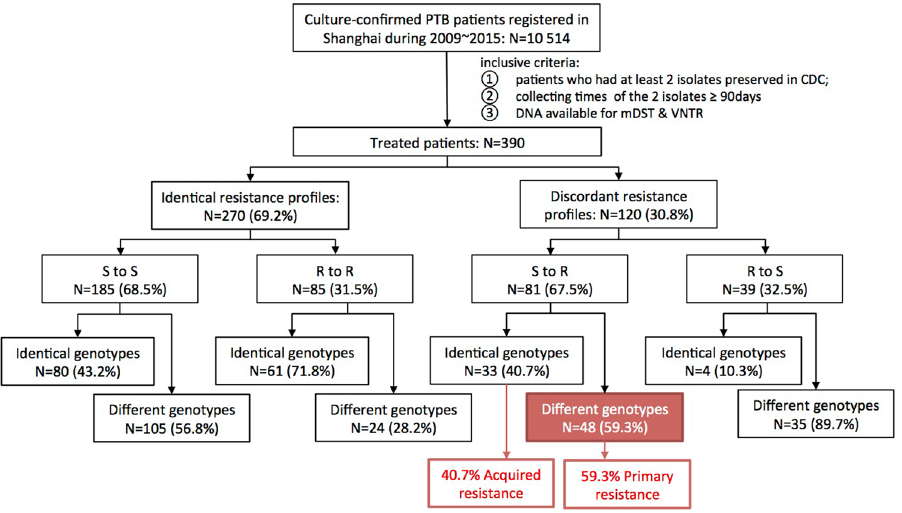
Figure 2. The Work Flow of the Study. Treated patients with at least two strains stored were enrolled; resistance changes were defined based on genotypes; different VNTR genotypes of the same patient indicate reinfection while identical genotypes of paired isolates suggested acquired resistance.